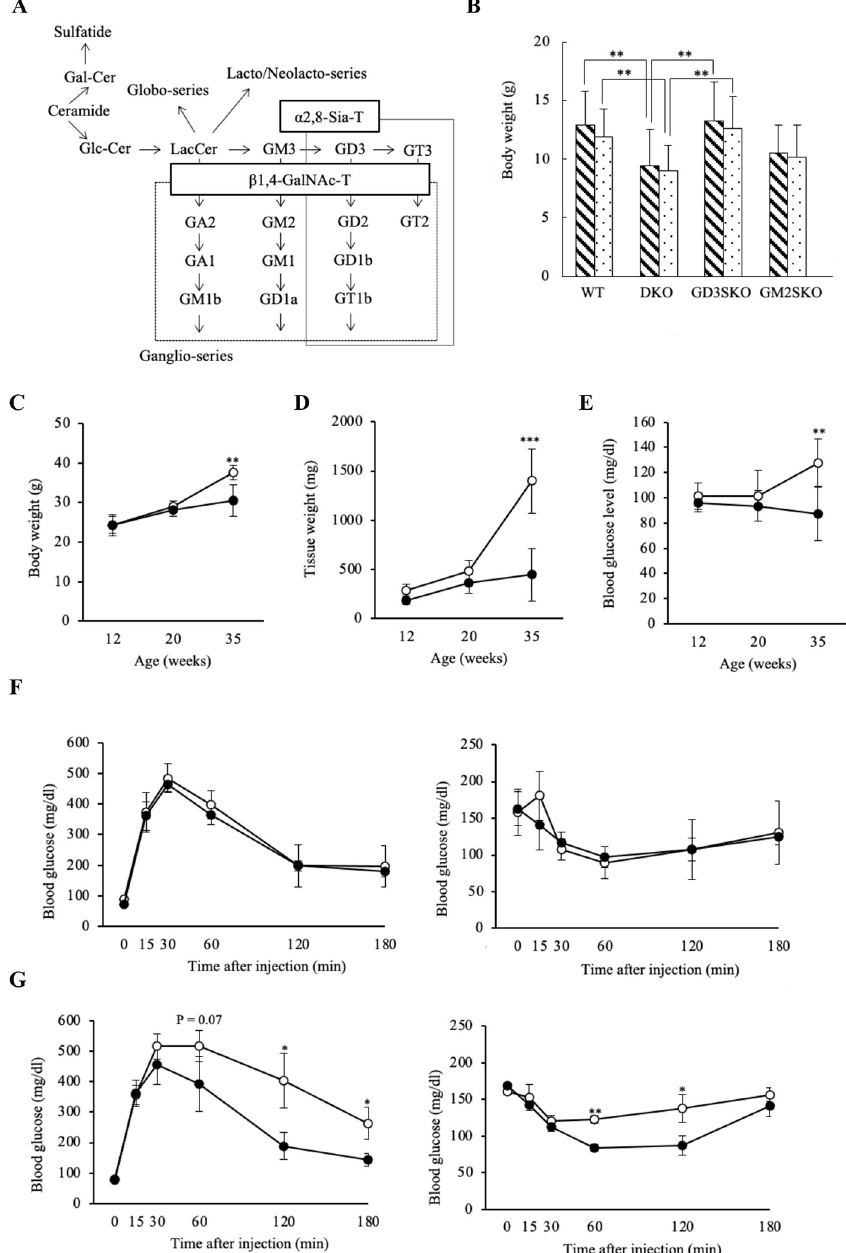
Fig 1. DKO mice expressing only GM3 did not show obesity and hyperglycemia. ( A ) A synthetic pathway of gangliosides. Ganglioside species that are absent in KO mice for GM2S ( β 1,4-GalNAc-T) and GD3S ( α 2,8-Sia-T) genes are enclosed by dotted line and solid line, respectively. Consequently, all structures boxed in two squares were depleted in DKO mice. ( B ) Body weights at 4 weeks of age in ganglioside-deficient mouse lines (more than 20 mice each). Oblique line and dot bars show male and female mice, respectively. Data are expressed as means ± S.D. �� P < 0.01 as compared with WT or GD3S-KO and DKO mice. ( C ) Body weights, ( D ) adipose tissue weights isolated from epididymal fat, and ( E ) blood glucose levels at 12 (3 mice each), 20 (5 mice each), and 35 weeks of age (6 mice each). Open and closed circles show WT and DKO mice, respectively. Data are expressed as means ± S.D. �� P < 0.01 and ��� P < 0.001 as compared between WT and DKO mice. ( F ) Blood glucose levels during GTT (left) and ITT (right) at 20 weeks of age (3 mice each). Open and closed circles show results of WT and DKO mice, respectively. Data are expressed as means ± S.D. ( G ) Blood glucose levels during GTT (left) and ITT (right) at 35–40 weeks of age (3 mice each). Open and closed circles show results of WT and DKO mice, respectively. Data are expressed as means ± S.D. � P < 0.05 and �� P < 0.01 as compared between WT and DKO mice.